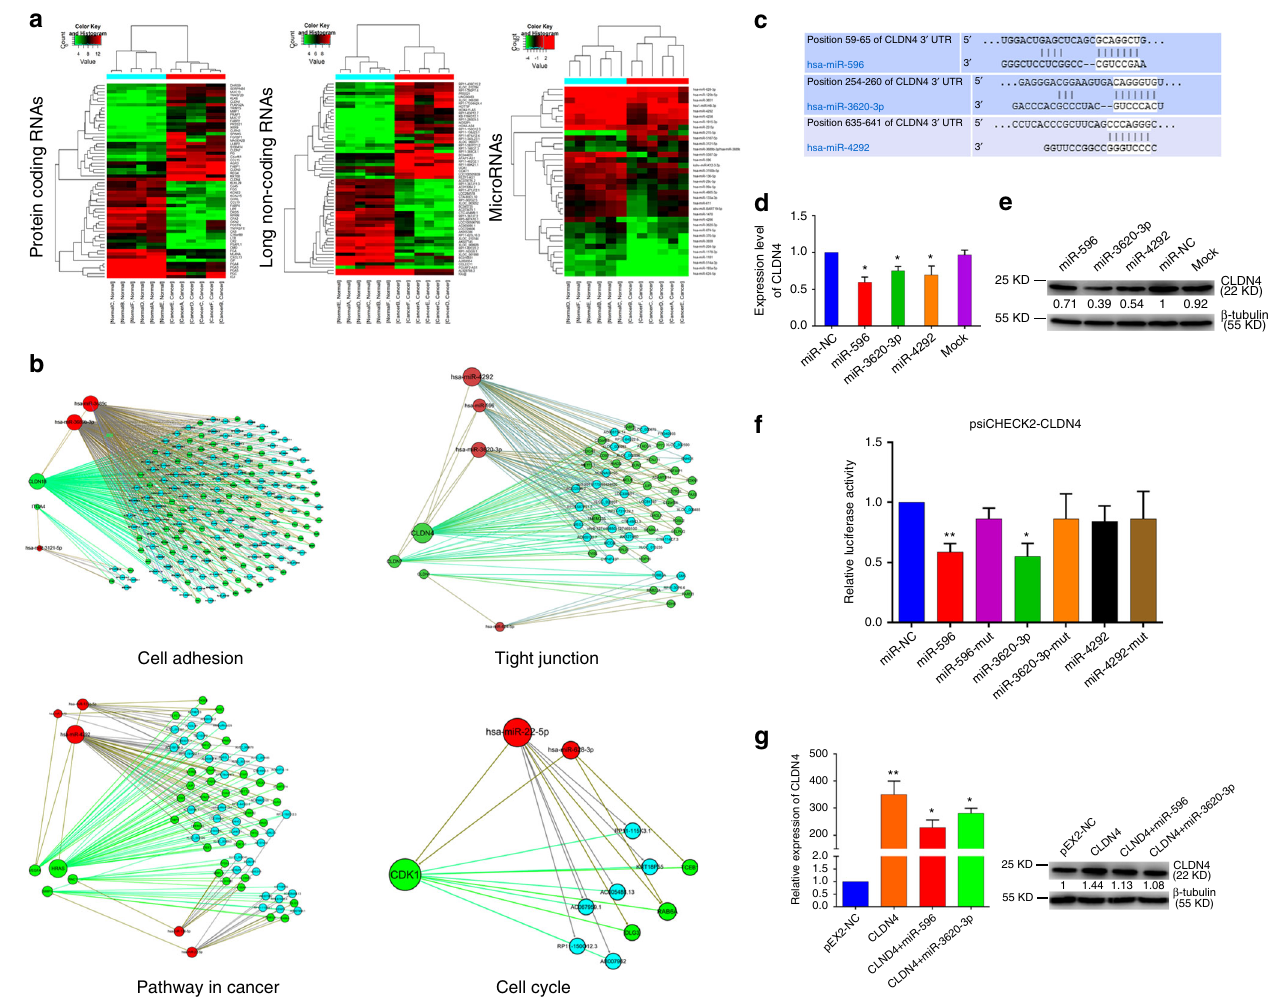
Fig. 1 CLDN4 is identi fi ed as a target of miR-596 and miR-3620-3p. a Hierarchical clustering analysis of mRNAs, lncRNAs, and miRNAs that were differentially expressed between GC tissues and non-tumorous adjacent tissues ( > 2.0-fold; P < 0.05; fi ltered to show the top 30 up-regulated or down-regulated results for mRNAs and lncRNAs). Expression values are represented in shades of red and green , indicating expression above and below the median expression value across all tissues, respectively. b The mRNA-lncRNA -miRNA networks in the GC. The networks include cell adhesion pathway, pathway in cancer, tight junction pathway, and cell cycle pathway. Genes colored in green are protein-coding RNAs associated with GC. Genes colored in blue are lncRNAs and genes colored in red are miRNAs associated with GC. c Predicted binding sites for miR-596, miR-3620-3p, and miR-4292 on the CLDN4 transcript. The white nucleotides are the seed sequences of miRNAs. d Real-time PCR analysis of CLDN4 expression in GC cells treated with mimics of miR-596, miR-3620-3p, miR-4292, and negative control. e GC cell line SGC-7901 was transfected with the mimics of miR-596, miR-3620-3p, miR-4292, and negative control. Reduced CLDN4 expression was shown by western blotting analysis and normalized to β -tubulin. f Luciferase activities were measured in GC cells co-transfected with luciferase reporter containing CLDN4 and the mimics of miR-596, miR-3620-3p, miR-4292, or mutant. Data are presented as the relative ratio of renilla luciferase activity and fi re fl y luciferase activity. g The relative expressions of CLDN4 were determined by real-time PCR and western blotting. Data are shown as mean ± s.d., n = 3. The data statistical signi fi cance is assessed by Student ’ s t -test. * P < 0.05, ** P <